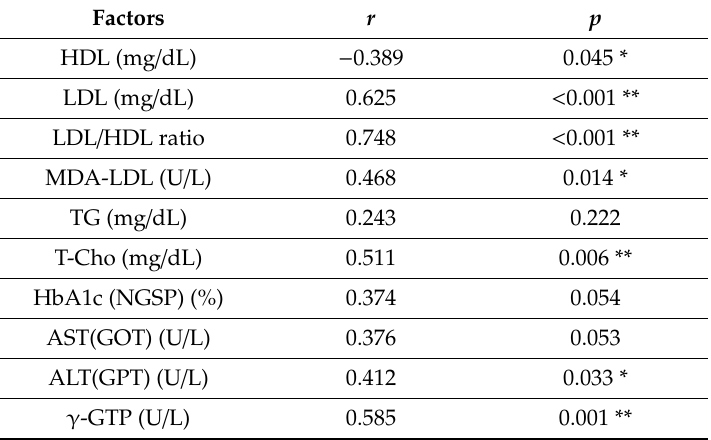
Table 5. Correlation between hs-CRP and the other systemic data.